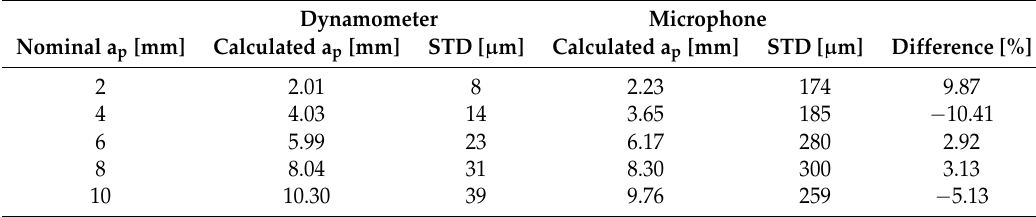
Table 5. Comparison between the dynamometer and the microphone values.